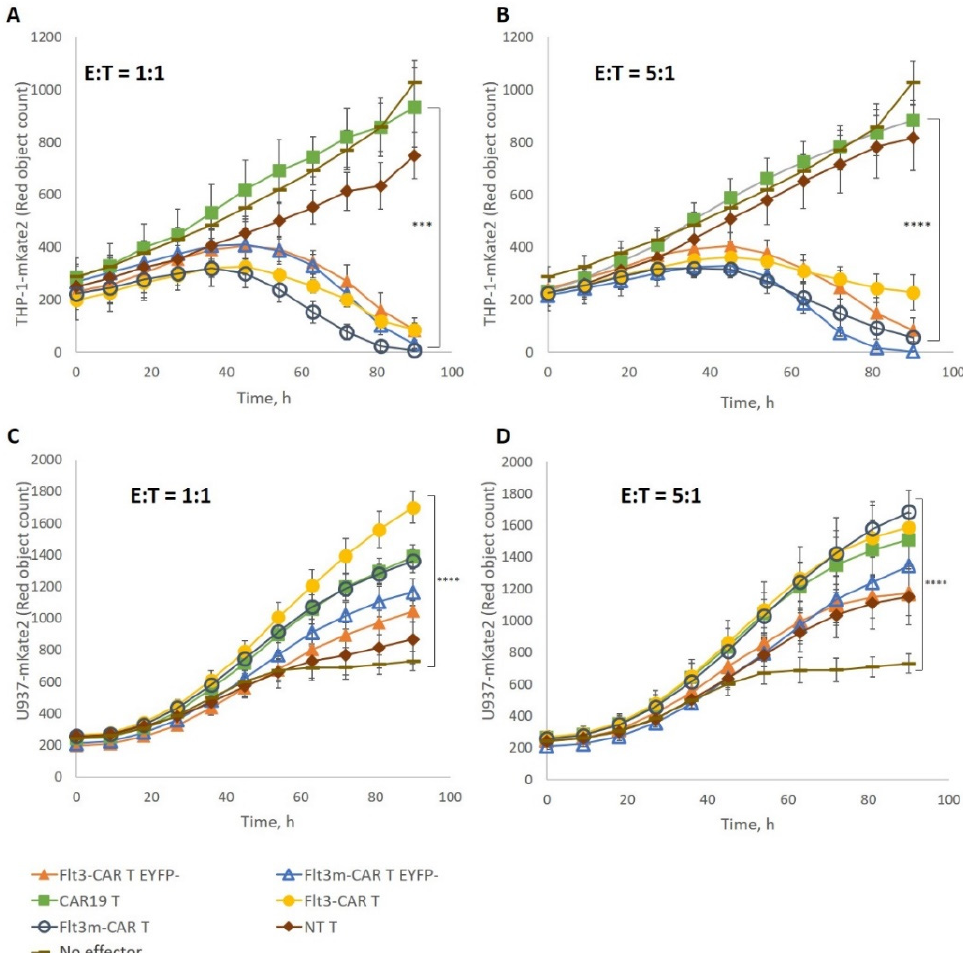
Figure 3. Specific Flt3m-CAR T-cell-mediated killing of target cells. Flt3m-CAR T-cells, Flt3m-CAR EYFP − T-cells, Flt3-CAR T-cells, Flt3-CAR EYFP − T-cells, CAR19 T-cells, and non-transduced (NT) T-cells were co-incubated with THP-1-mKate2 cells at an E:T ratio of 1:1 ( A ) or 5:1 ( B ) or with U937-mKate2 cells at an E:T ratio of 1:1 ( C ) or 5:1 ( D ). Empty dark blue circles refer to Flt3m-CAR T-cells, empty blue triangles to Flt3m-CAR EYFP − T-cells, yellow circles to Flt3-CAR T-cells, orange triangles to Flt3-CAR EYFP − T-cells, green squares to CAR19 T-cells, brown diamonds to NT T-cells, and dashes to wells with THP-1-mKate2 or U937-mKate2 cells without any effector cells. Red object counts are shown in the figure, indicating the number of alive THP-1-mKate2 or U937-mKate2 cells. Data are represented as mean ± SD. Mann–Whitney U-tests and Kruskal–Wallis tests were performed to identify significant differences. *** p < 0.001; **** p < 0.0001.